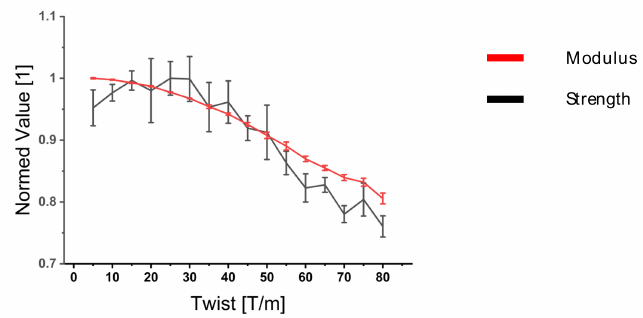
Figure 14. Parameter study of yarn twist influence on composite properties.